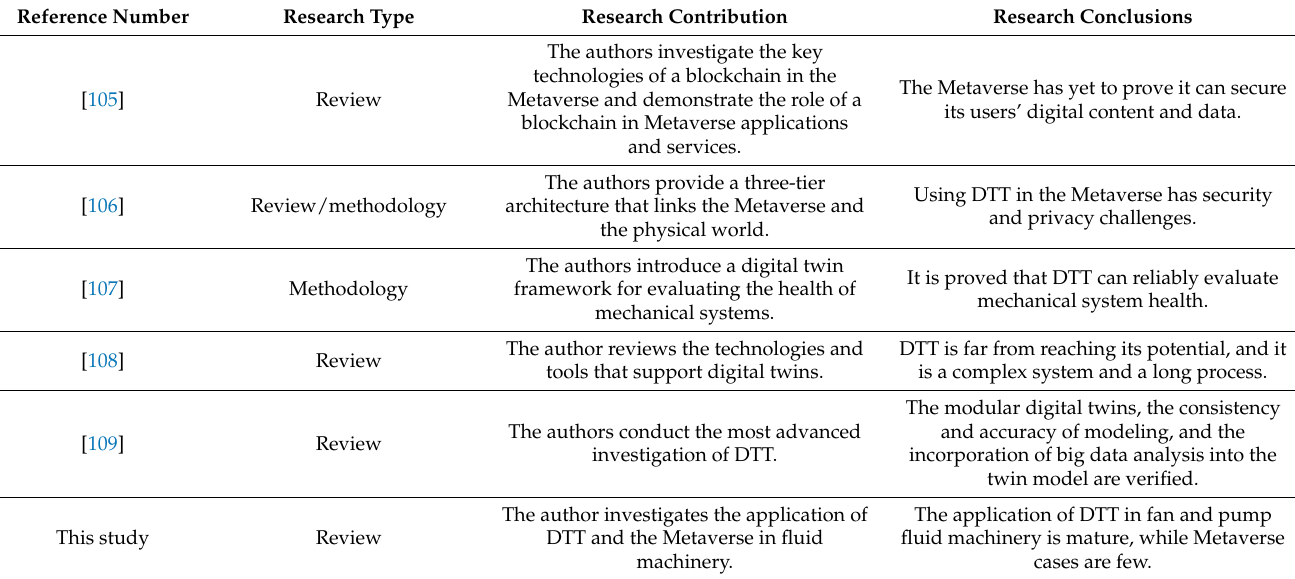
Table 2. Comparison of main research results between this study and other similar published